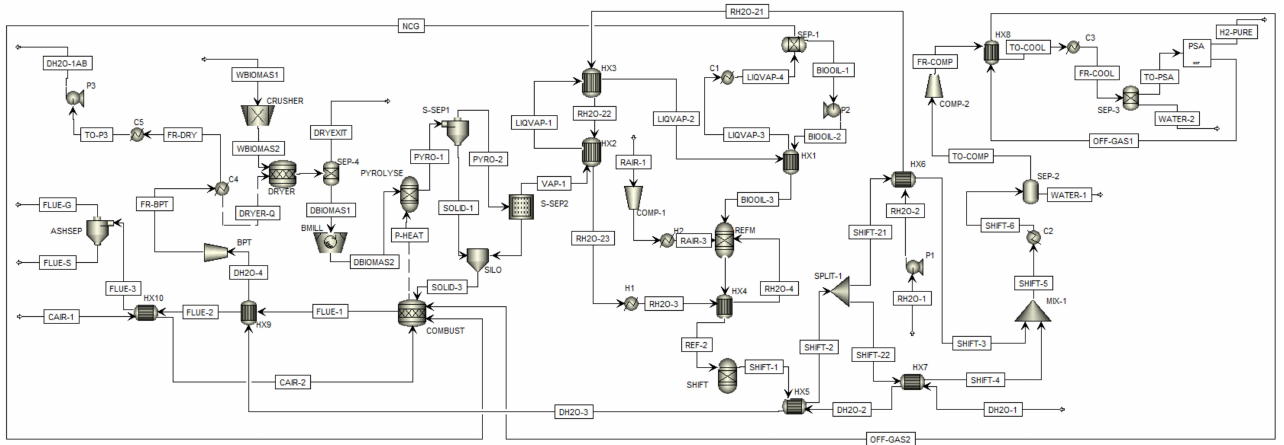
Figure 9. Flowsheet for a heat integrated PAPS-BT process: pyrolysis and autothermal reforming process with hydrogen separation by PSA, featuring combined heat (HX9) and power by backpressure turbine